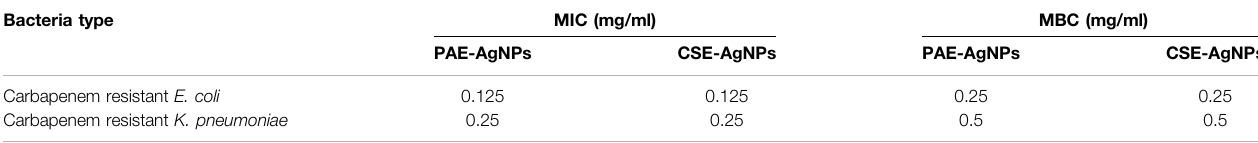
TABLE 5 | Sensitivity tests of AgNPs green-synthesized by PAE and CSE extract showing the inhibitory zone in millimeters. Organism Distilled water inhibitory Carbapenem-resistant E. coli 0 10